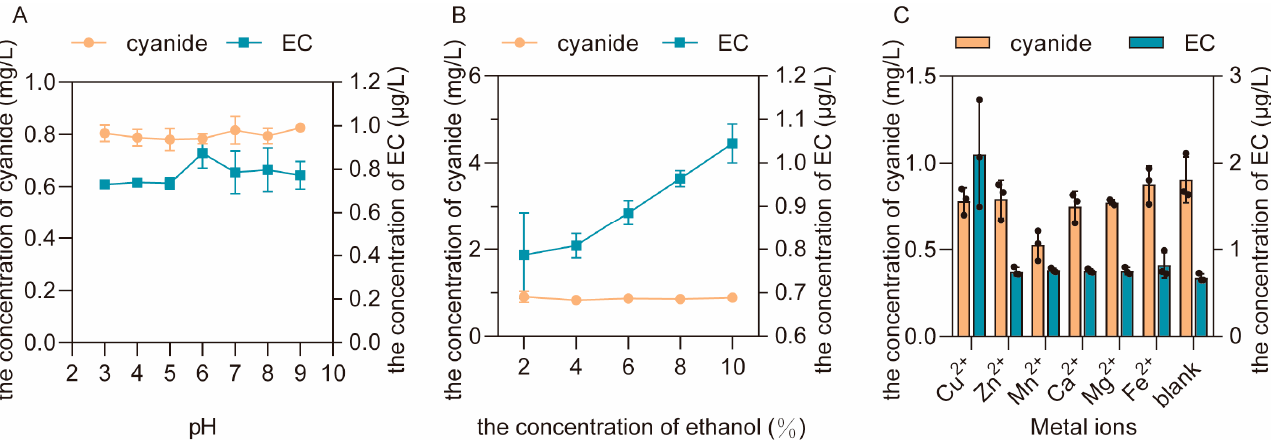
Figure 6. The effects of pH value ( A ), alcohol concentration ( B ) and metal ions ( C ) on the formation of EC and the residue of cyanide in aqueous reactions.